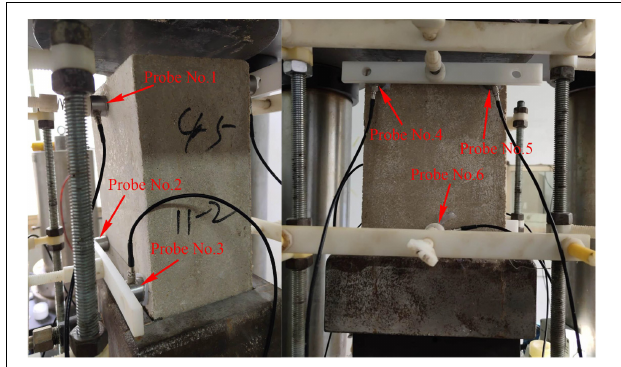
FIGURE 10 | Images showing the locations of acoustic emission probes with respect to the specimen.